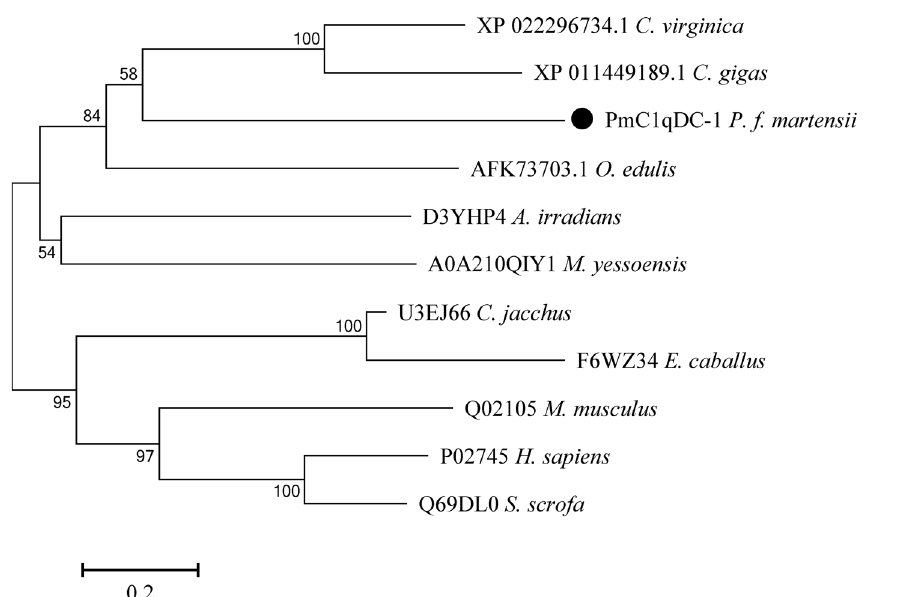
Figure 2. Neighbor-joining (NJ) tree of PmC1qDC-1 ( ) with other C1qDC proteins. The tree was constructed by the NJ algorithm via MEGA 7 based on the multiple sequence alignment by muscles. Bootstrap ● values of 1000 replicates (%) are indicated for the branches. The scale bar corresponds to 0.2 estimated amino acid substitutions per